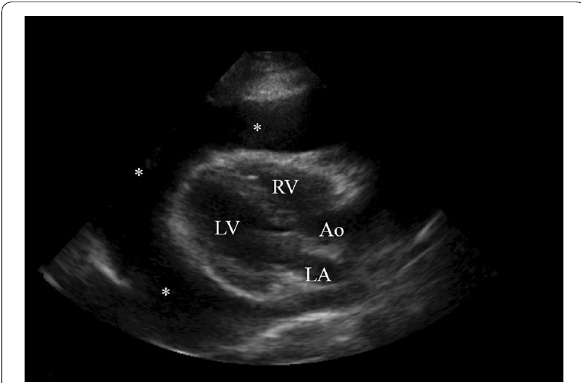
Fig. 1 POCUS, Case 1. Parasternal long-axis view of pericardial tamponade with a large circumferential pericardial effusion (*). The classic “swinging heart” was visualized in real-time ultrasonography.